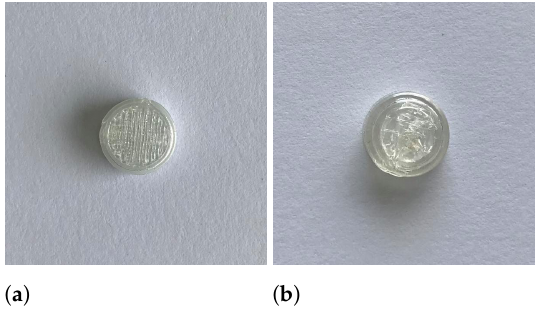
Figure 11. The influence of layer height on the visual quality of the resulting tablet: 0.4 mm ( a ), 0.8 mm ( b ). Reproduced with permission from [18], Elsevier,